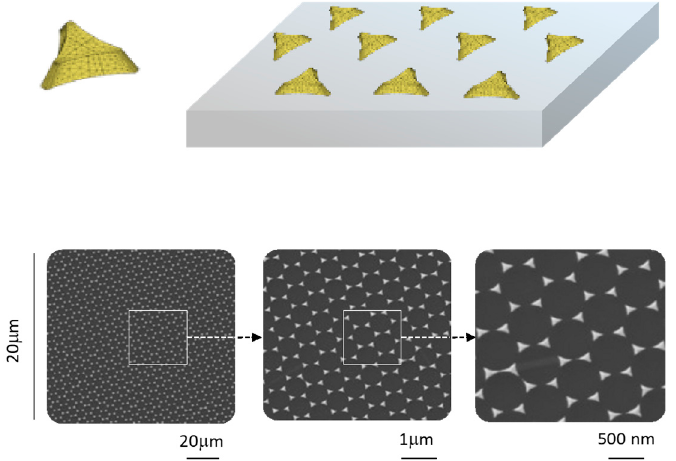
Figure 4. Schematic illustration, low and high magnification SEM images of the gold nano prism realized by NSL on glass substrate with PS NS of 500 nm in